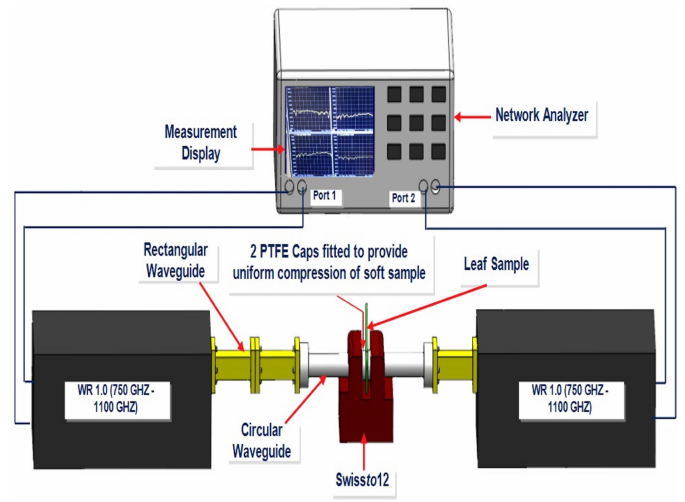
Figure 2. Schematic representation of experimental setup used for measurement of leaf sample. The leaf sample is placed between the two PTFE caps fitted to